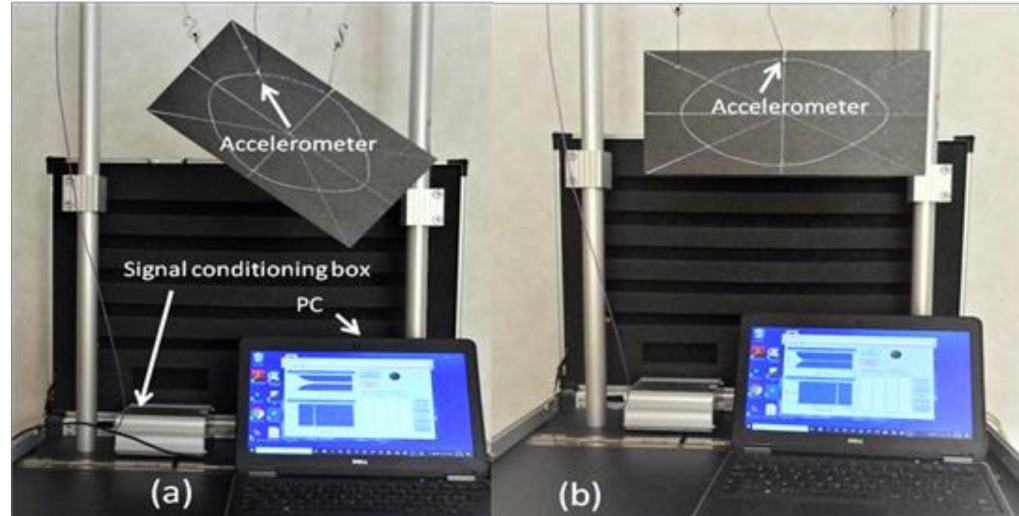
Figure 10. Test setup for measuring the damping ratios with IET: An aluminium suspension frame and the DJB micro accelerometer connected through a signal conditioning box with a PC; in ( a ) the accelerometer is fixed with beeswax on the intersection of the nodal lines of the saddle and breathing mode shapes; in ( b ) the accelerometer is fixed on the intersection of torsion and breathing mode shape. The measured decaying sinusoidal signal can be curve fitted with the formula (26). A curve fitting example is shown in Figure 11.